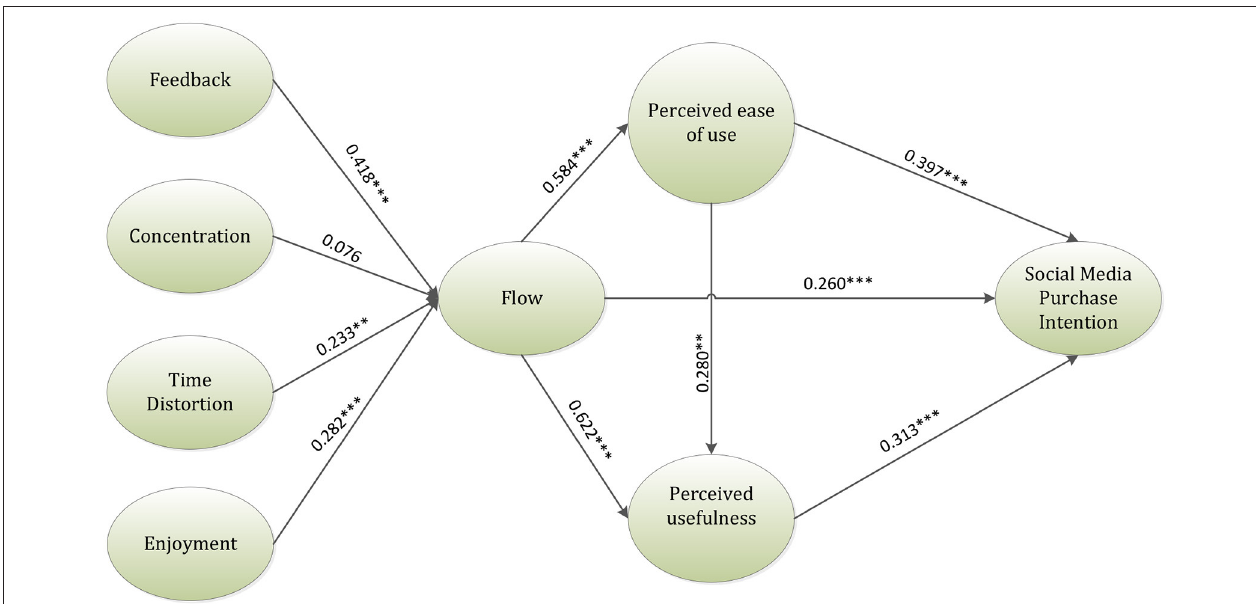
FIGURE 2 | A framework of the inner model result. ** p